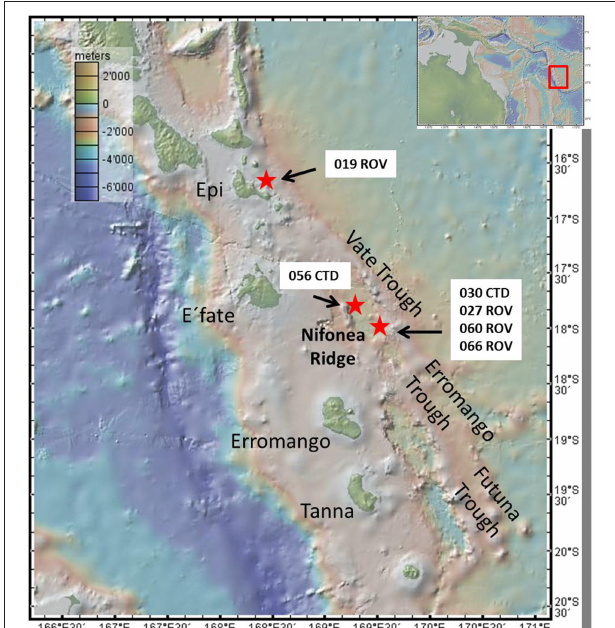
FIGURE 1 | Map showing the New Hebrides Island arc with the islands of Vanuatu, the three Trough systems and the Nifonea Ridge as well as Epi Caldera, including all sampling stations. Map was created using